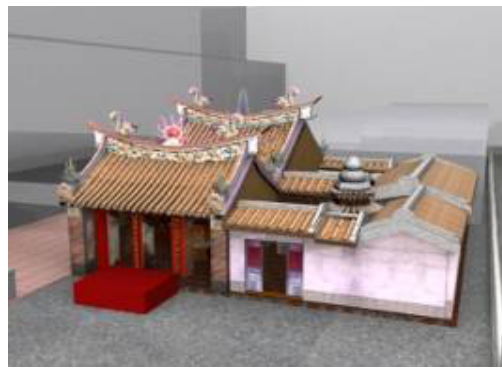
Figure 6. 3D data of Taipei Xia Hai City God Temple